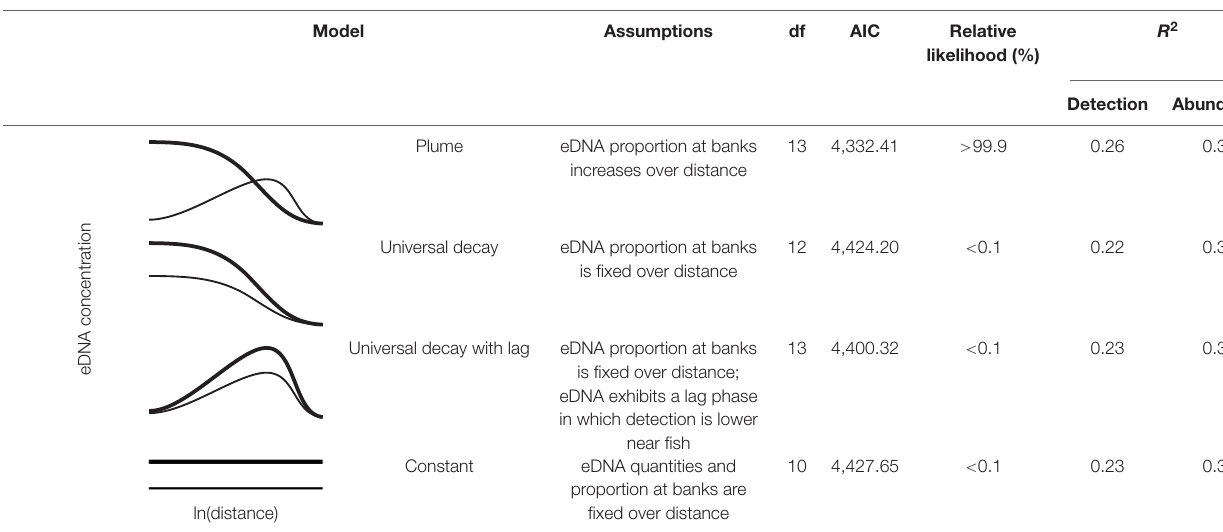
TABLE 4 | Comparison of four eDNA dispersal